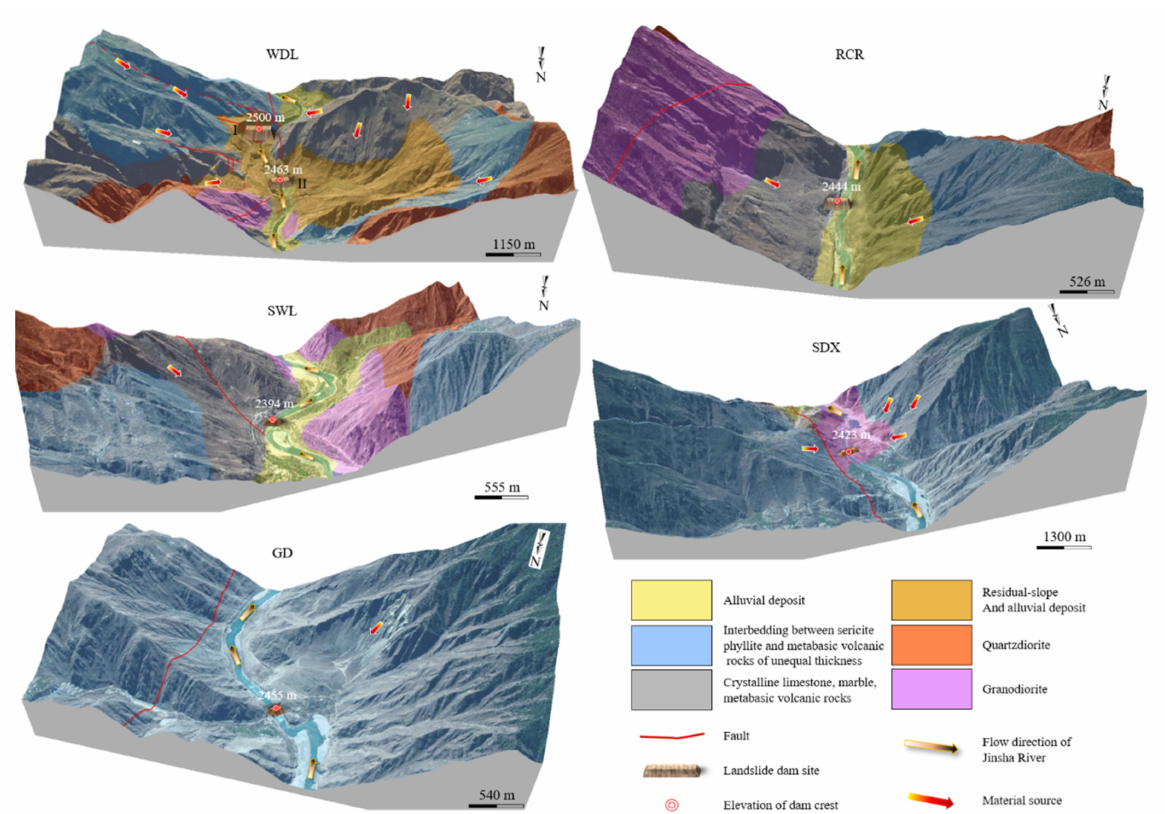
Figure 2. Map showing the specific geological settings of the dam site. Note: Due to the limitations in data collection, WDL, RCR and SWL were generated according to 1:50,000 geological map; SDX and GD were generated according to 1:200,000 geological map. (Note: these figures were created by ArcGIS